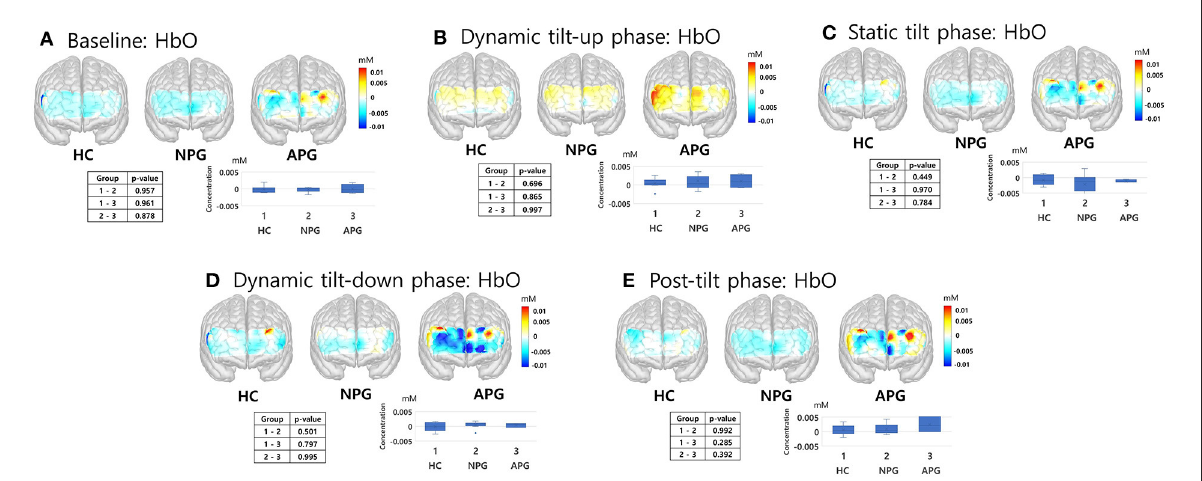
FIGURE5 fNIRS responses of HC, NPG, and APG participants during the five HUT tasks. (A) Baseline, (B) dynamic tilt-up phase, (C) static tilt phase, (D) dynamic tilt-down phase, and (E) post-tilt phase. Kruskal-Wallis test was used for statistical analysis; statistical significance was set at p < 0.05. APG, electrical burn patients with abnormal HUT results; fNIRS, functional near-infrared spectroscopy; HbO, oxyhemoglobin; HC, healthy controls; HUT, head-up tilt table test; NPG, electrical burn patients with normal HUT results.